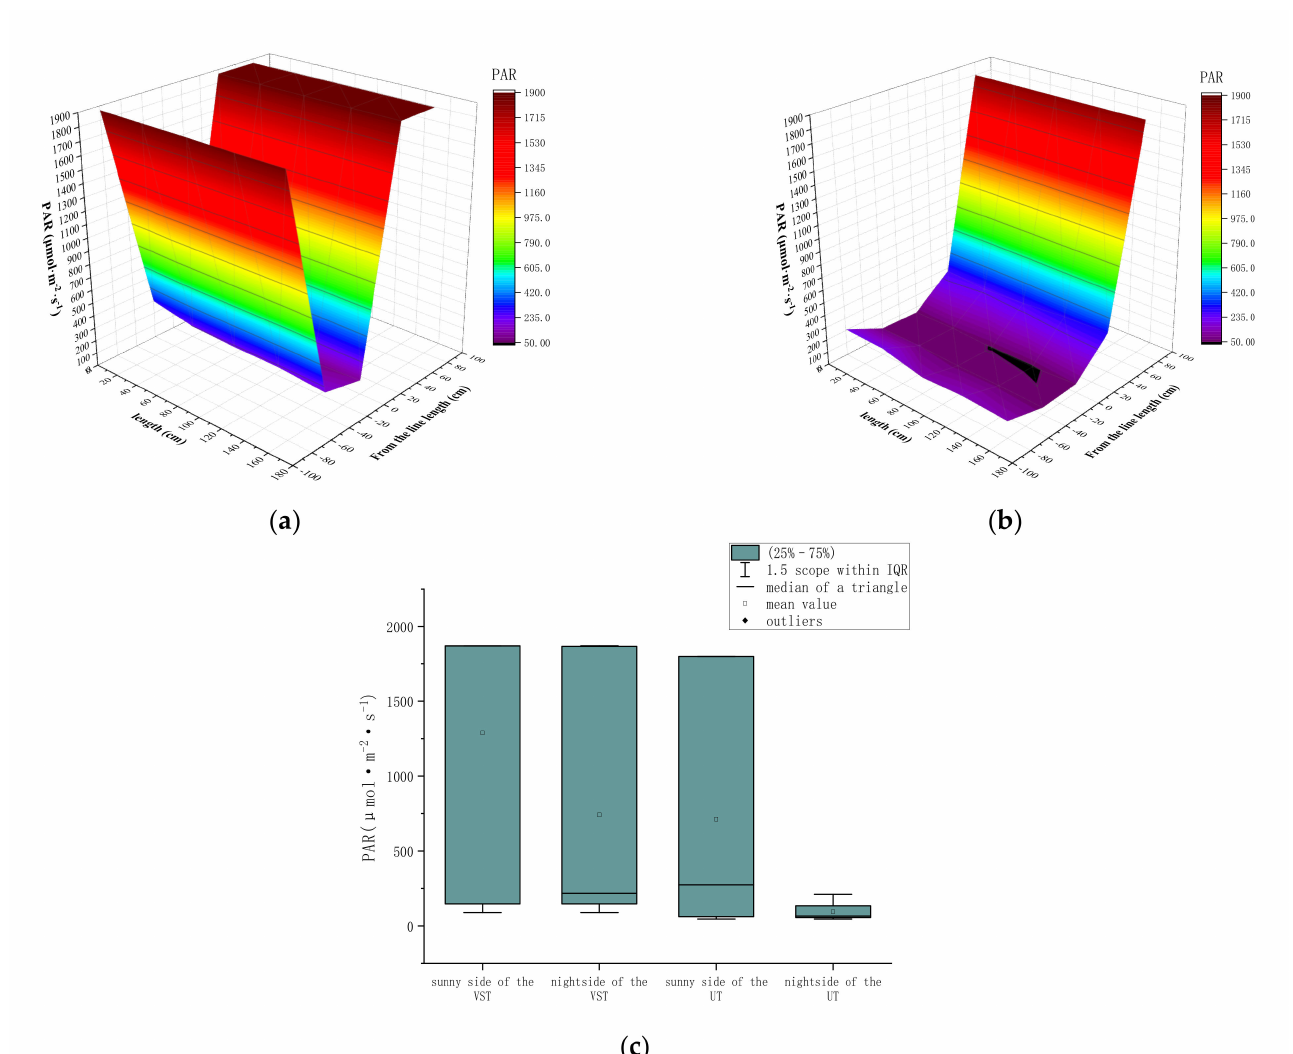
Figure 3. Effects of canopy types on the spatial distribution of photosynthetic active radiation. Distribution of photosynthetic active radiation (PAR) on the surface of VST canopy ( a ) and UT canopy ( b ), and the distribution of PAR data ( c ). Values are the mean of three replicates and error bars denote the SD. Different lowercase letters indicate significant differences based on Duncan’s multiple range test ( p <